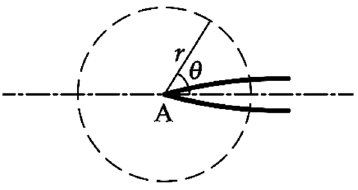
Figure 13. Von Mises stress distributions in the vicinity of the crack tips: ( a ) SC, ( b ) PCS7, ( c ) PCS17, and ( d ) PCS0. Points A-D are the four crack tips shown in Figure 1.